Question: In a single sentence, describe what this figure presents.
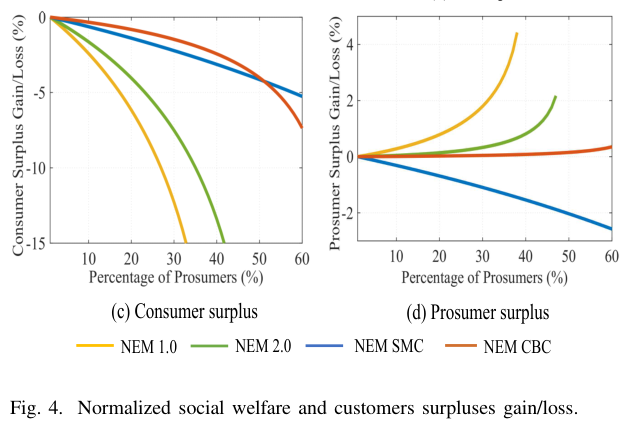
Answer: Normalized social welfare and customers surpluses gain/loss.